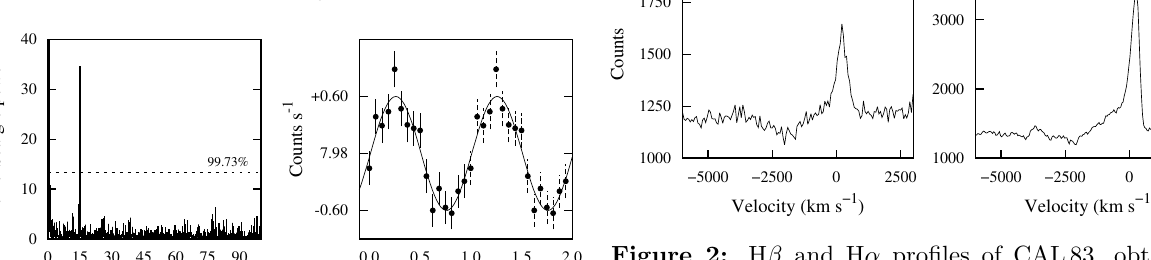
Figure 2: H β and H α profiles of CAL 83, obtained with SALT on 2 Feb